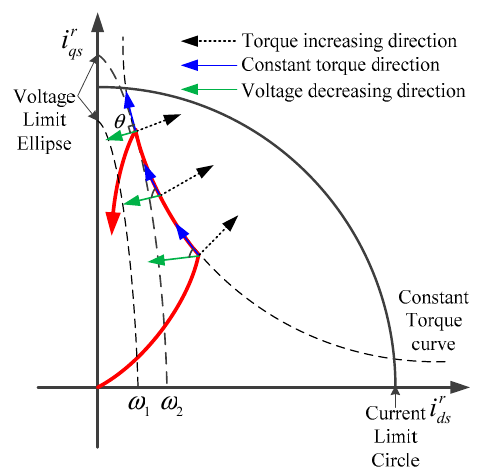
Figure 4. Flux weakening directions of the SynRM.